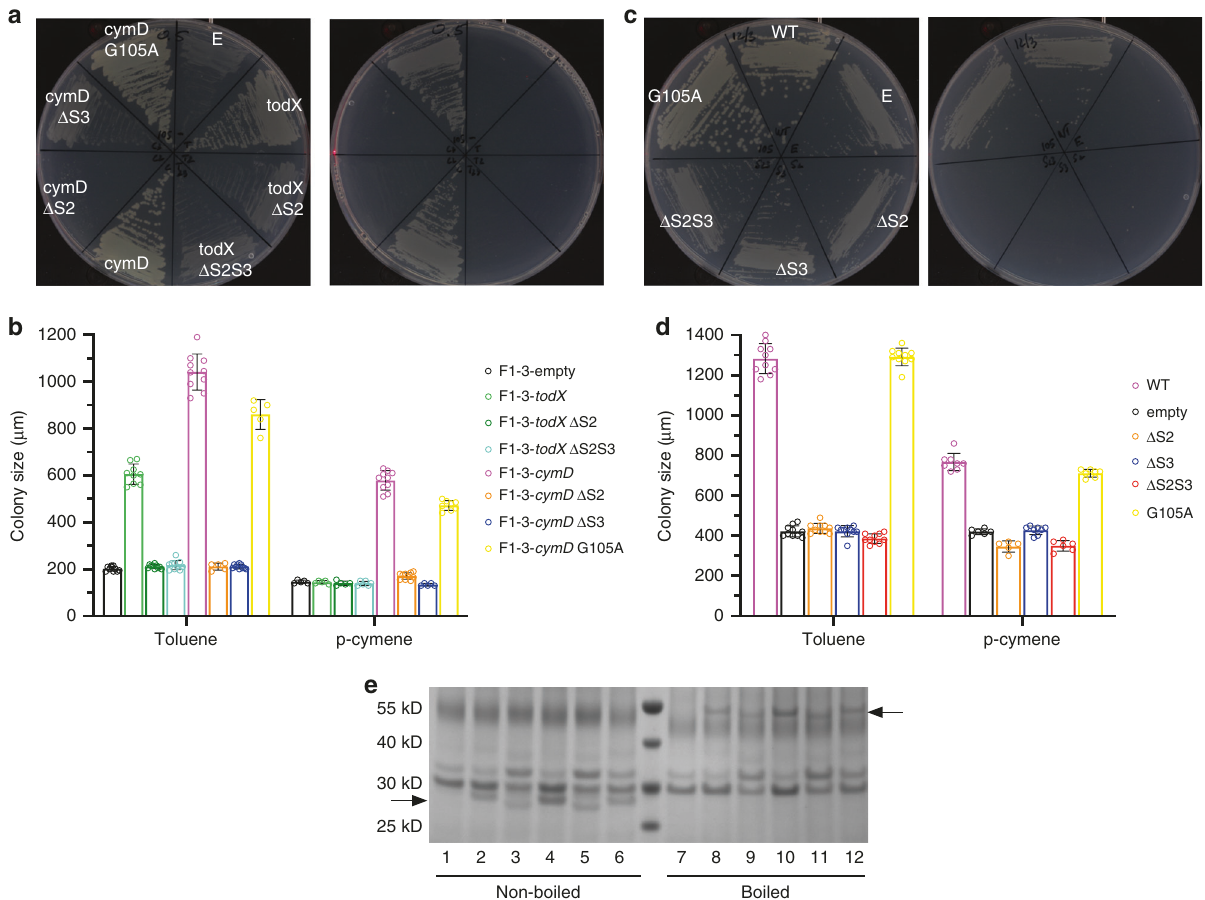
Fig. 5 Lateral opening mutants of TodX and CymD have impaired MAH uptake. a Representative growth of Tn7-complemented Pp F1-3 strains on toluene (left panel) and p-cymene vapour in the presence of 0.5% arabinose. Growths shown are representative of 2 or 3 plates. b Corresponding maximum colony sizes from ( a ), taken from two different plates (mean ± S.D; n = 6 – 10). c Representative growth of pHERD30-complemented Pp F1-3 strains on toluene (left panel) and p-cymene vapour in the presence of 0.1% arabinose. Growths shown are representative of 2 or 3 plates. d Corresponding maximum colony sizes from c , taken from 2 different plates (mean ± S.D; n = 6 – 10). e Coomassie-stained SDS-PAGE gel of pHERD30-complemented Pp F1-3 strains after IMAC. lanes 1/7, empty plasmid; lanes 2/8, CymD wild type; lanes 3/9, CymD Δ S2; lanes 4/10, CymD Δ S3; lanes 5/11, CymD Δ S2S3; lanes 6/12 CymD G105A. Arrows indicate approximate positions of CymD variants before (lanes 1 – 6) and after boiling (lanes 7 – 12). As is the case for many OMPs, CymD remains partially folded in SDS without boiling, leading to faster migration in the gel and a lower apparent molecular weight (~31 kD compared to ~48 kD after boiling). Molecular weight markers are indicated on the left. The gel picture shown is representative of two independent expression analyses. Source data for colony sizes are provided in the Source Data fi